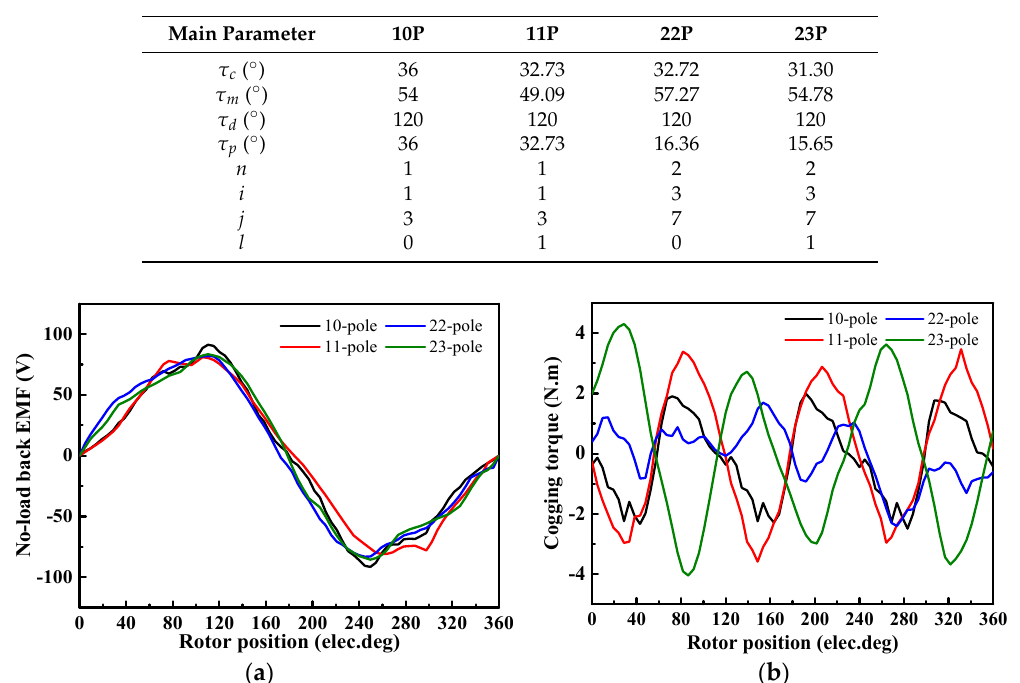
Table 2. Different parameters of MSOR-FSPM motors.